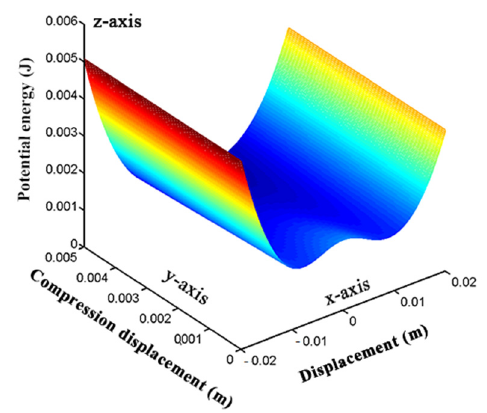
Figure 7. Potential curve of the system at different compression displacement of the spring.